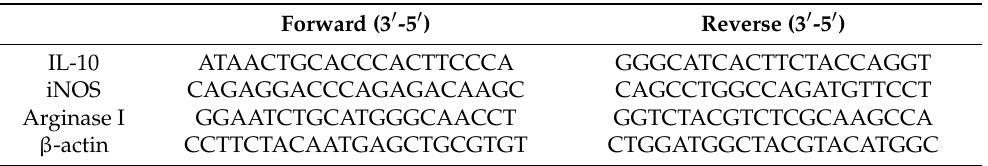
Table 2. RT-qPCR